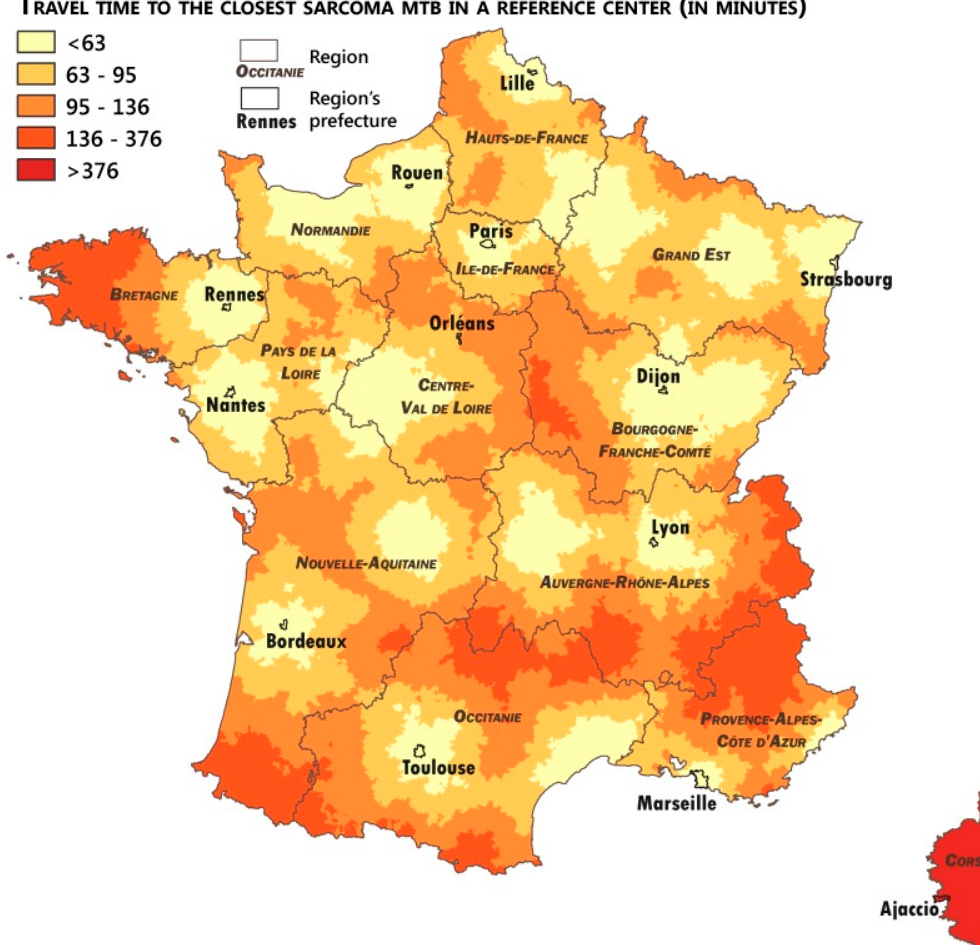
Figure 4. Access to sarcoma clinical expertise by mainland French communes.